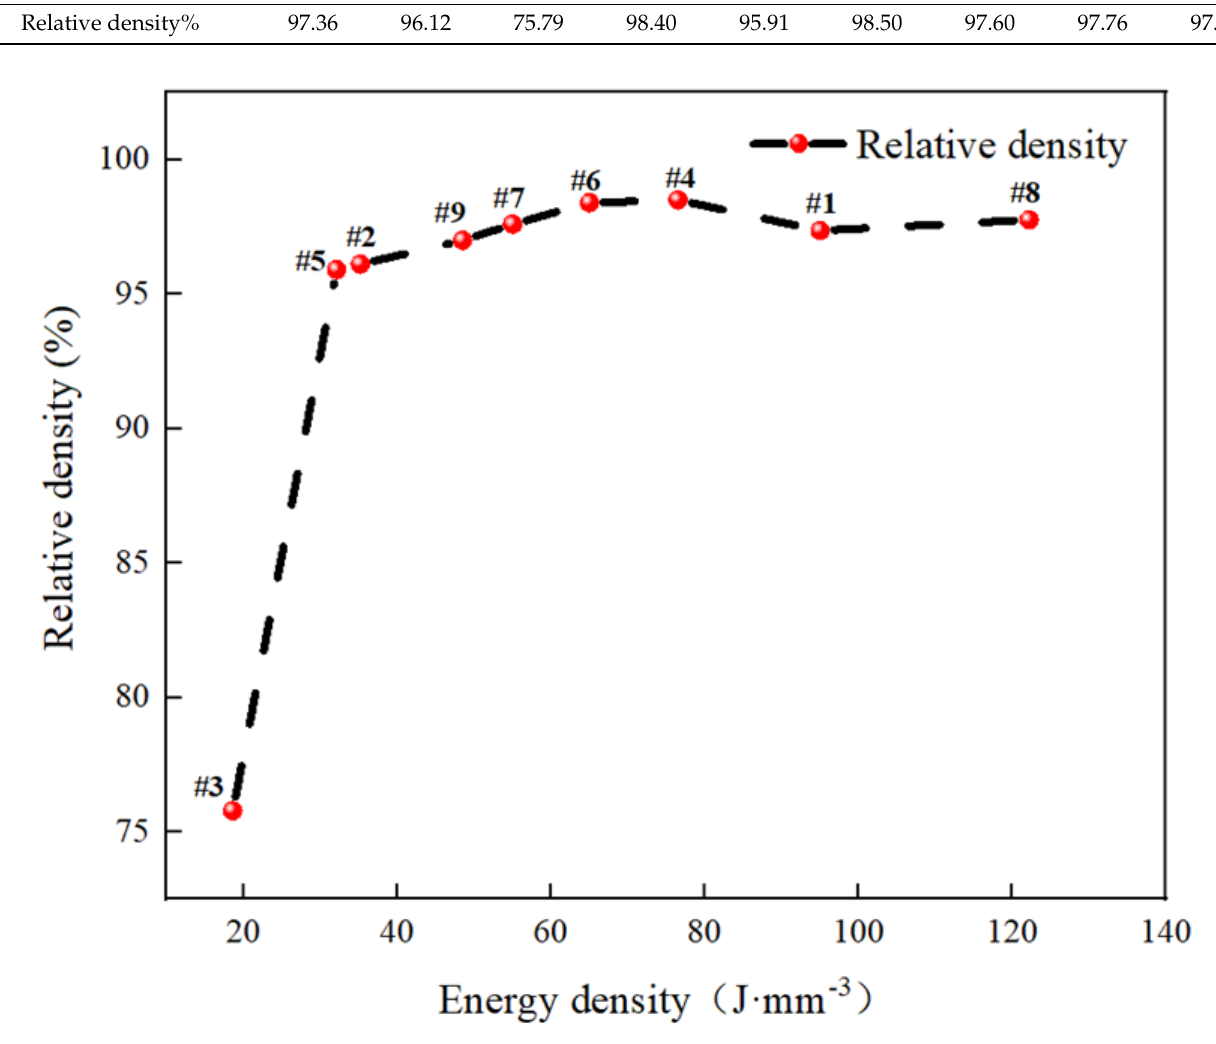
Figure 5. Effect of laser energy density Ev on relative density percentage of as-fabricated 316 L stainless steel.